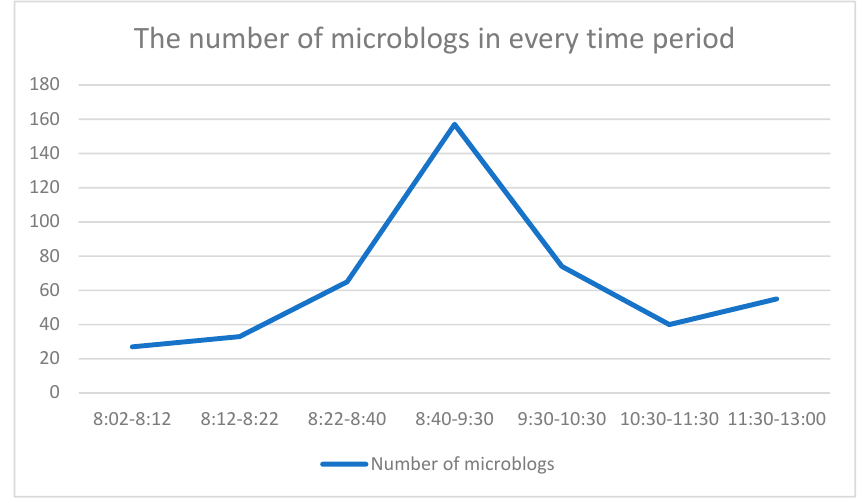
Figure 7. Changes of the crowd amount in each small time period.